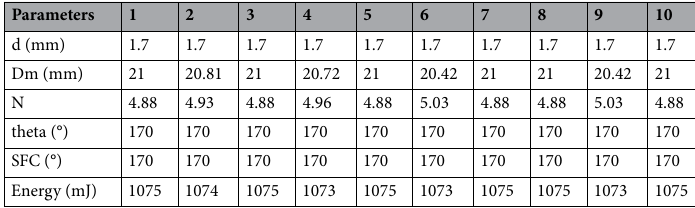
Table 4. Optimization results for torsion spring—Scenario 2.